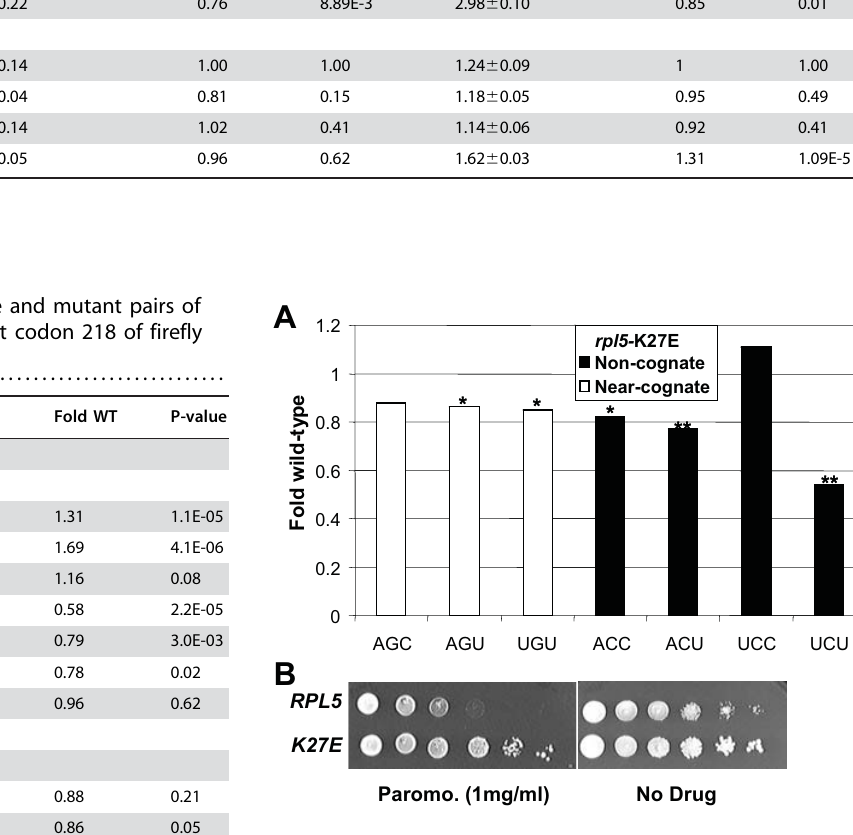
Figure 4. Characterization of alleles of RPL5.Panel A. Effects of the K27E rpl5 mutanton misreading of seven missense codons. Effects on the indicated missense reporters are depicted as fold of isogenic wild- type cells. ** indicates p values of , 0.01. Panel B. Paromomycin dilution spot assays. Ten-fold dilutions (10 6 R 10 1 CFU) of logarithmically growing cells were arrayed onto H-leu medium containing paromo- mycin (1 mg/ml) or no drug control plates. Cells were grown at 25 u C for 3